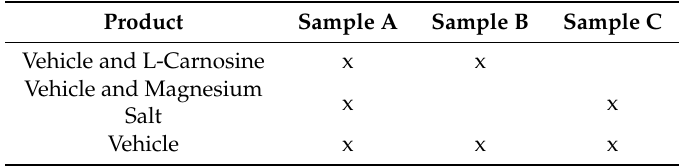
Table 1. Sample A: Magnesium-carnosine complex in the vehicle; Sample B: Free carnosine, without the complexing agent, in the same vehicle; Sample C: Magnesium salt in the same vehicle. Product Sample A Sample B Sample C Vehicle and L-Carnosine x Vehicle and Magnesium x Vehicle x x